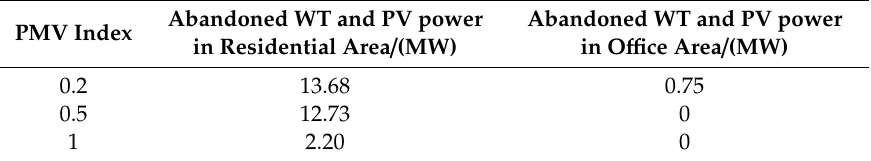
Table 8. Abandoned WT and PV power in functional areas under di ff erent PMV indexes.